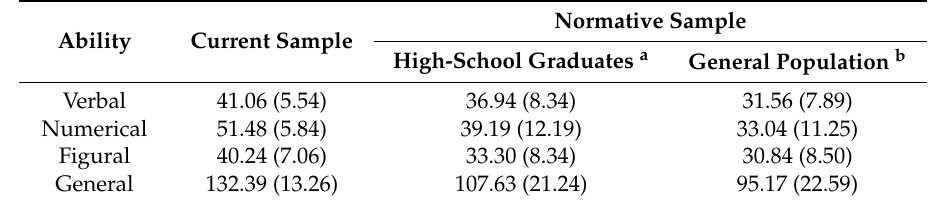
Table 3. Means and standard deviations (in parentheses) of raw sum-scores on the IST in the present sample and in two normative